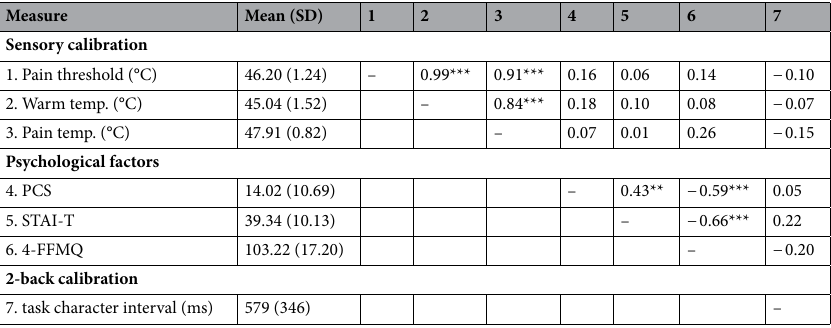
Table 1. Descriptives and intercorrelations of calibration parameters and psychological and cognitive factors. Means and Pearson product-moment intercorrelations are presented for behavioral task parameters, thermal stimulus calibration parameters, and psychological and executive functions measures. PCS = Pain Catastrophizing Scale, PCS sum score ranges from 0 to 52; STAI-T = State-trait Anxiety Inventory—Trait, STAI-T score ranges from 20 to 80; 4-FFMQ = Five-Facet Mindfulness Questionnaire (Observe dimension omitted from total), FFMQ Act with Awareness, Describe, Nonjudge, Nonreact sum score ranges from 32 to 160: *** p < 0.001, ** p < 0.01.